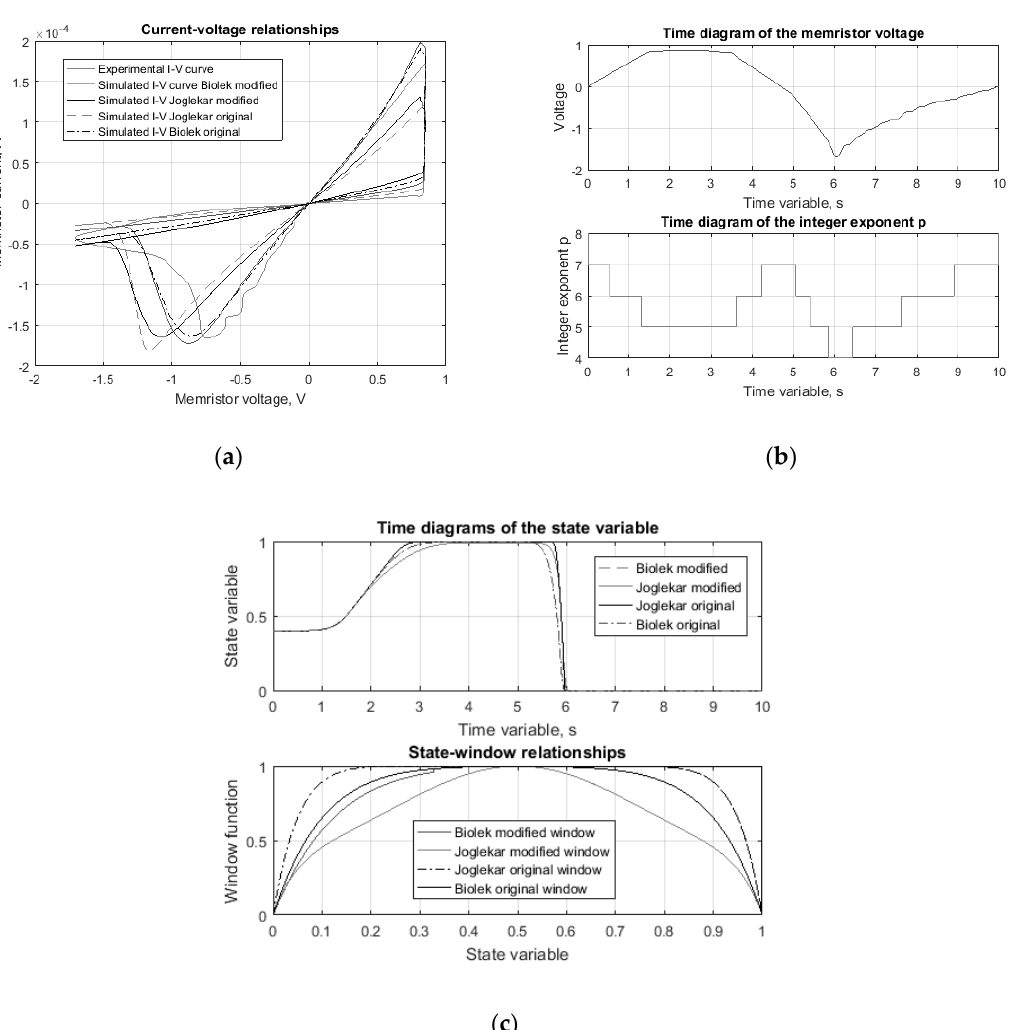
Figure 1. ( a ) Experimental and simulated current-voltage characteristics of the HfO 2 memristor; ( b ) Time diagrams of the applied voltage and the integer exponent; ( c ) Window function-state relationships of the used HfO 2 memristor models.